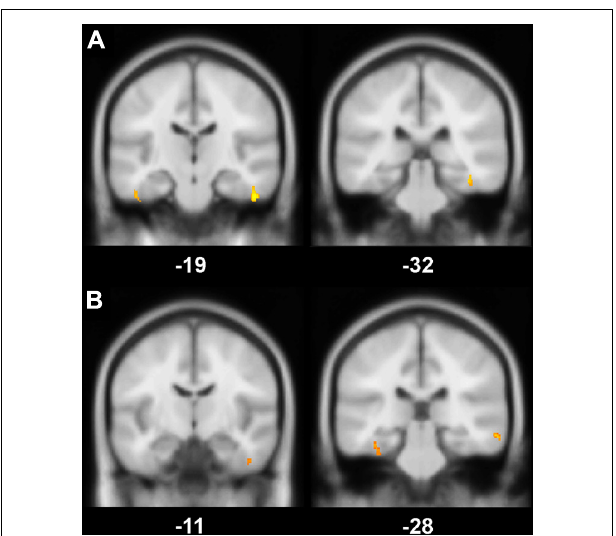
FIGURE 1 | (A) Gray matter (GM) volume differences in patients compared to controls (contrast controls > patients).The slice on the left shows volume reductions in left and right fusiform gyrus (BA 20), the slice on the right illustrates volume loss in the right perirhinal cortex (BA 36); (B) Positive correlation between the magnitude of the familiarity old/new effect with GM volume. On the left, a cluster in right fusiform gyrus (BA 20) correlates significantly with the familiarity effect, on the right, there is a significant correlation between left perirhinal cortex (BA 36) and the familiarity effect; Significance level is P uncorrected < 0.005 with a cluster threshold of 40 contiguous